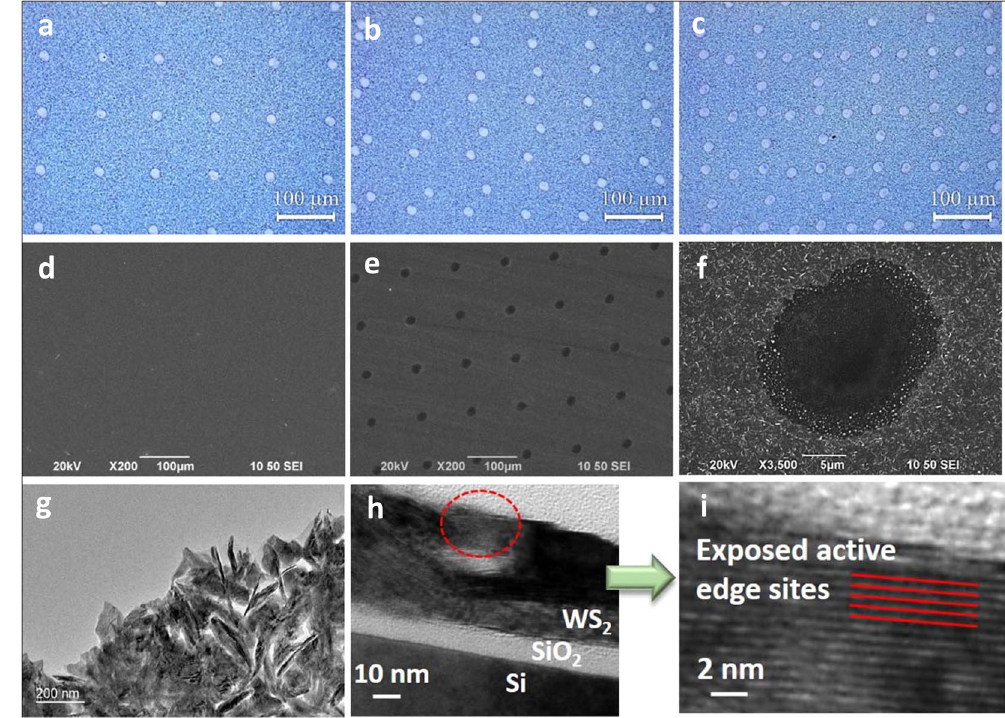
Figure 3. Optical images of WS 2 film with laser treatment ( a ) once; ( b ) twice; ( c ) three times. SEM images of WS 2 film ( d ) before laser treatment; ( e , f ) after one laser treatment. ( g ) TEM image of transferred WS 2 film with laser-drilled hole. ( h ) HRTEM cross-section image of laser treated WS 2 film. ( i ) Zoom-in HRTEM image of the hole area as indicated in ( h ) by red dot